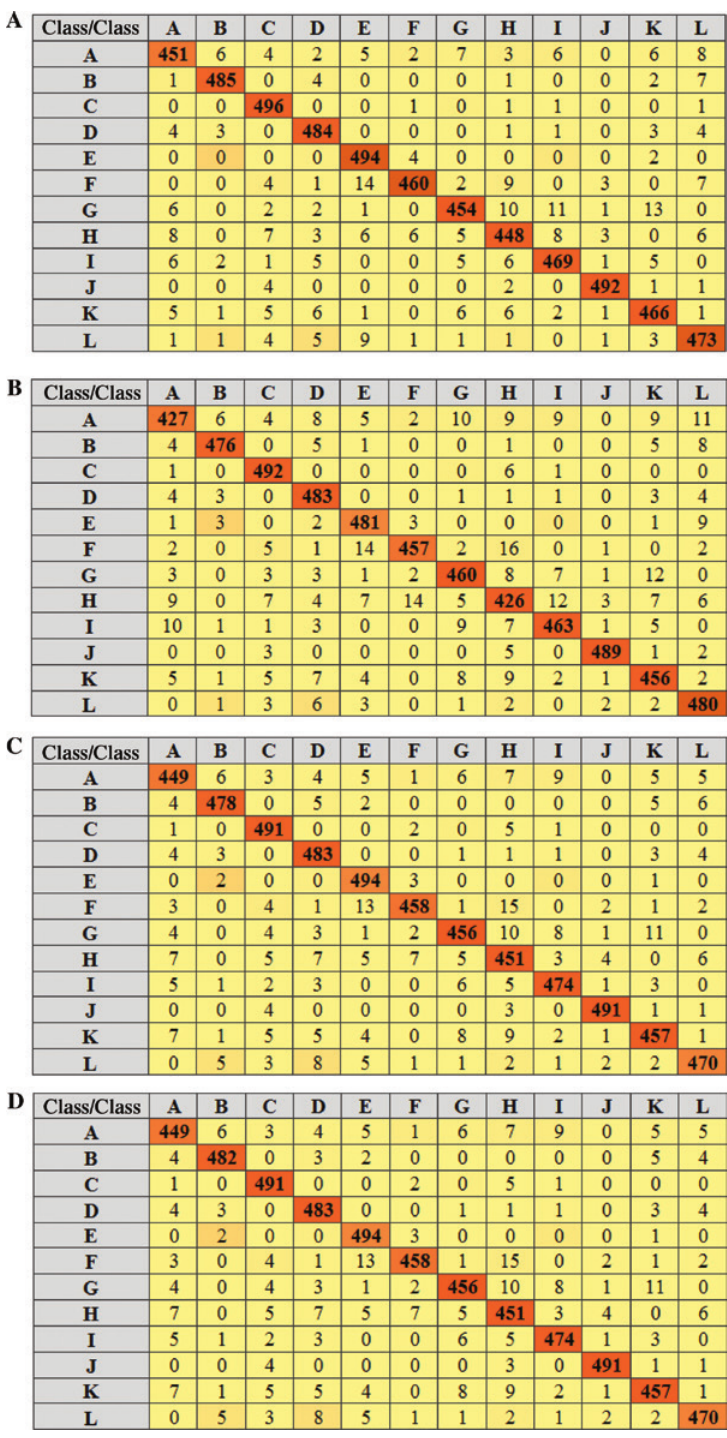
Figure 11: Class-Wise Classification Statistics Obtained by (A) First Procedure, (B) Second Procedure, (C) Third Procedure, and (D) Fourth